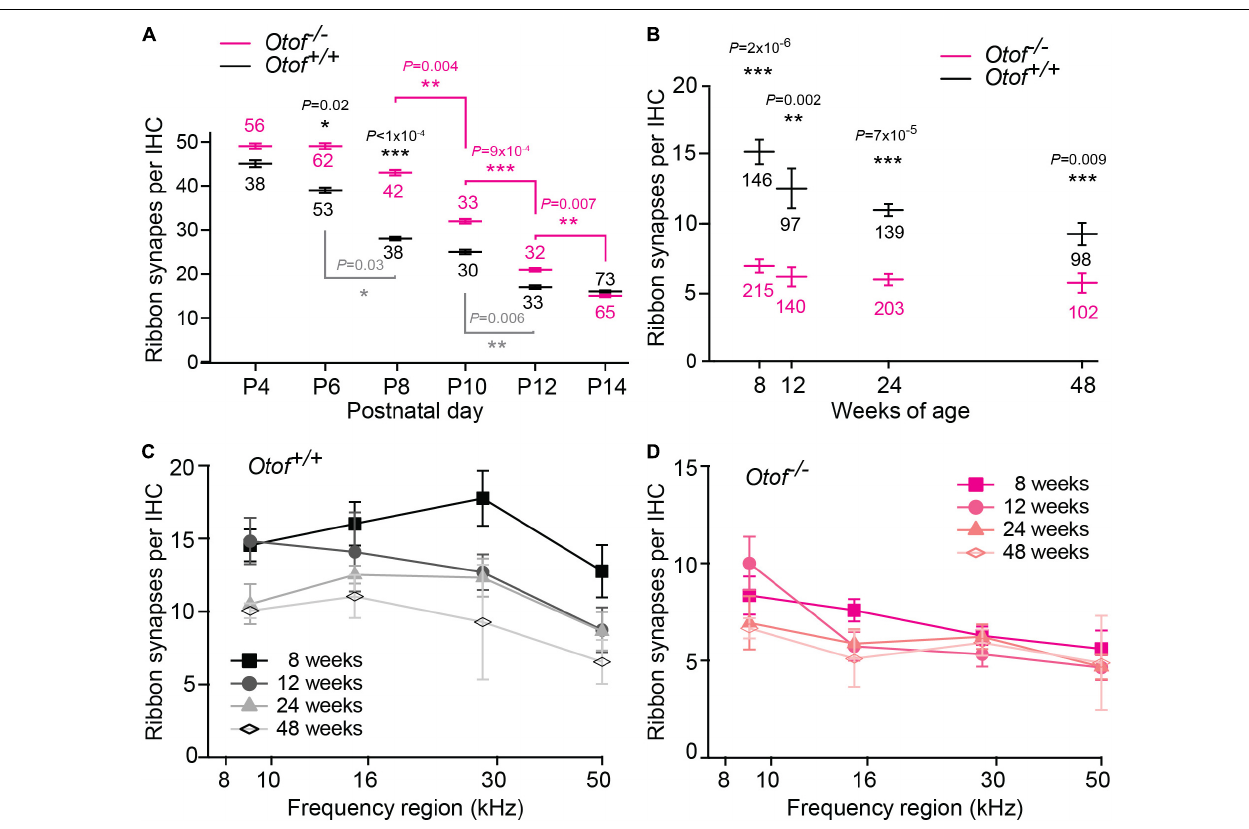
FIGURE 3 | Decline of afferent synapses over time. (A) Quantification of afferent synapses (as juxtaposed signals of Ctbp2 and Shank1a) between postnatal day 4 and 14 (P4, P14) from immunolabeling as presented in Figure 2 ; n = 30–73 IHCs, as indicated in the figure, apical region with exception of the most apical ∼ 640 µ m (P6 and P14 re-plotted from Al-Moyed et al., 2019). Only statistically different results between Otof + / + and Otof − / − IHCs are indicated (black p values), as well as significant changes during development within Otof + / + (gray) and within Otof − / − samples of different ages (magenta). (B–D) Numbers of synapses (as juxtaposed immunolabeling of Ctbp2 punctae with Na/K-ATPase labeled boutons); (B) between 8 and 48 weeks of age, averaged from synapse counts in the four regions of the cochlea indicated in Figure 1B ( Otof − / − : 8 weeks: N = 7 cochleae; 12 weeks N = 5, 24 weeks: N = 8, 48 weeks: N = 4; wildtype: 8 weeks N = 5; 12 weeks: N = 3; 24 weeks: N = 4; 48 weeks: N = 4; IHC numbers are indicated in the figure). (C,D) Numbers of synapses per IHC plotted against cochlear frequency region for Otof + / + (C) and Otof − / − (D) IHCs. Statistics: (A) Kruskal-Wallis test followed by Dunn’s multiple comparison test; (B) F-test followed by Student’s t -test. ∗ p < 0.05; ∗∗ p < 0.01; ∗∗∗ p <